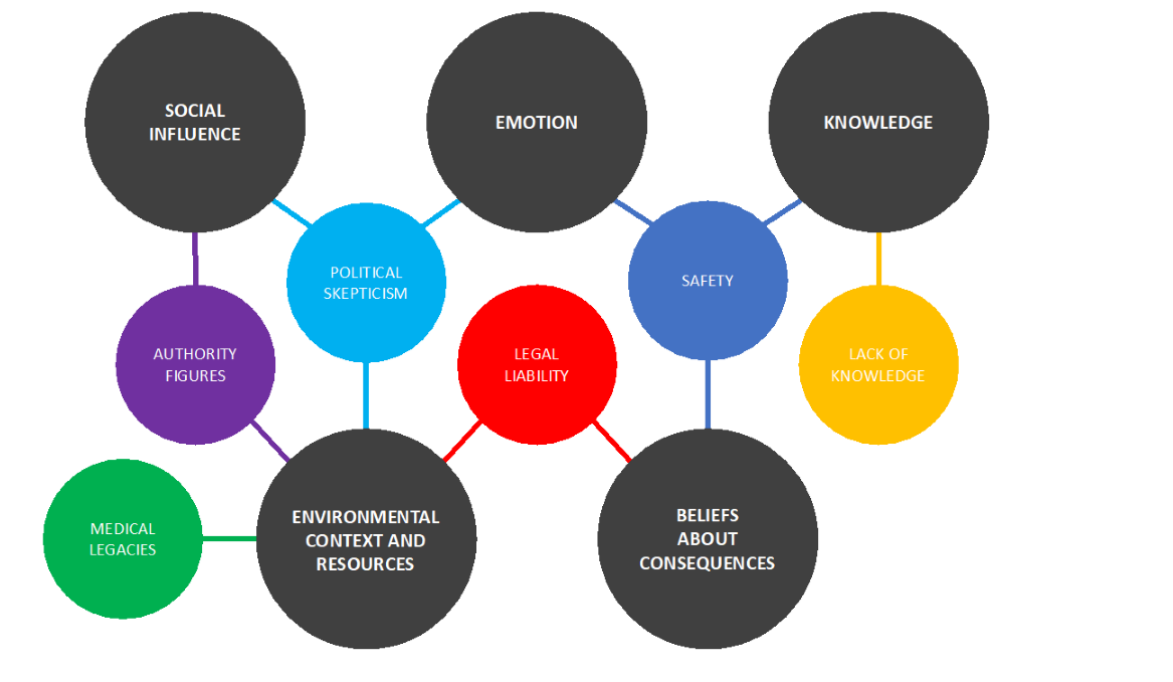
Figure 4. Themes were categorized based on the TDF. The TDF domains are represented by the dark-gray circles. The themes from the content analysis (smaller colored circles) were mapped to relevant TDF domains. TDF: Theoretical Domains